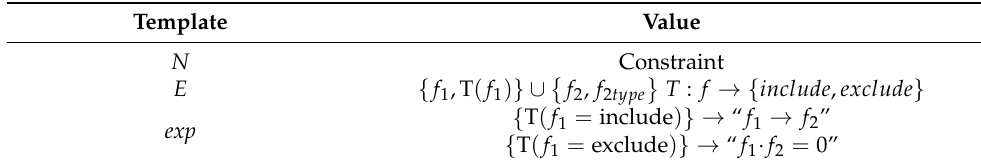
Table 2. Constraint